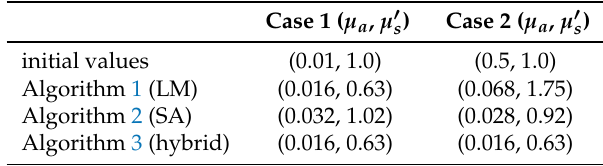
Table 1. Reconstructed values of µ a , µ (cid:48) s are shown for Case 1 and Case 2. The units of µ a , µ (cid:48) s are both mm − 1 . For Algorithm 2, values at 120th Monte Carlo step are